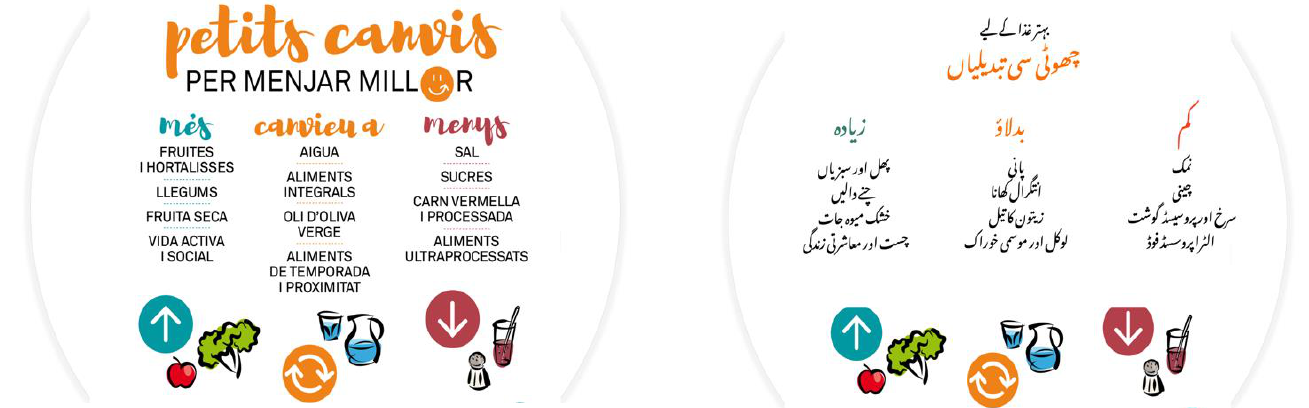
Figure 4. Translation of “ Petits canvis per menjar millor (small changes to eat better)”.